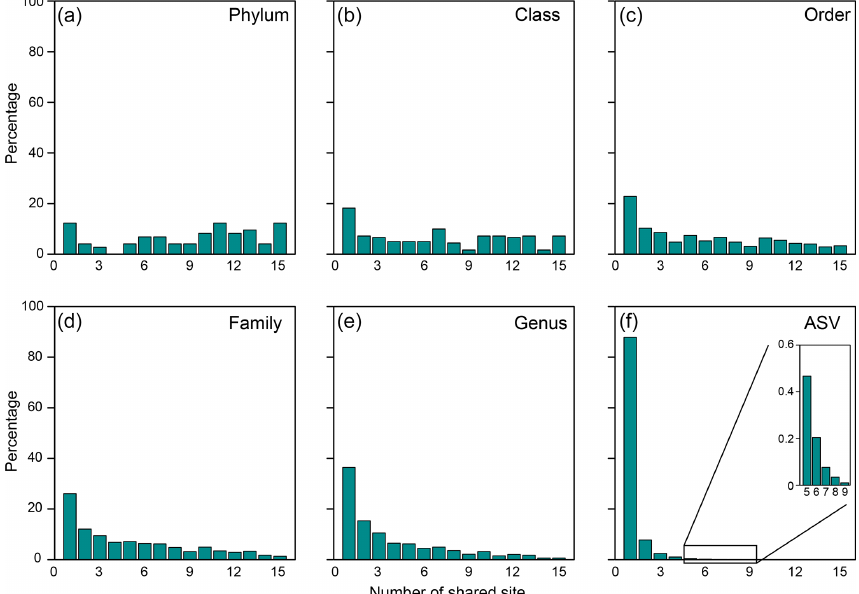
Figure 3. Proportions of specific taxonomical units shared between the number of MVs for the (a) phylum, (b) class, (c) order, (d) family, (e) genus, and (f) ASV.